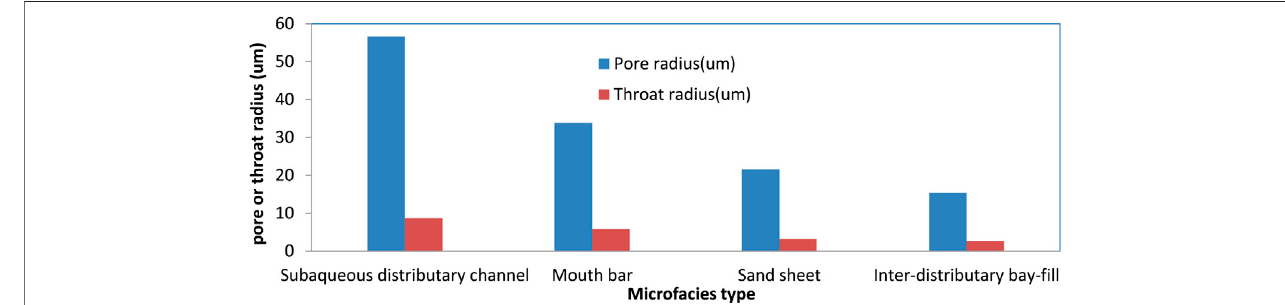
FIGURE 12 | Statistical chart of relationship between sandstone pore and throat size and microfacies.